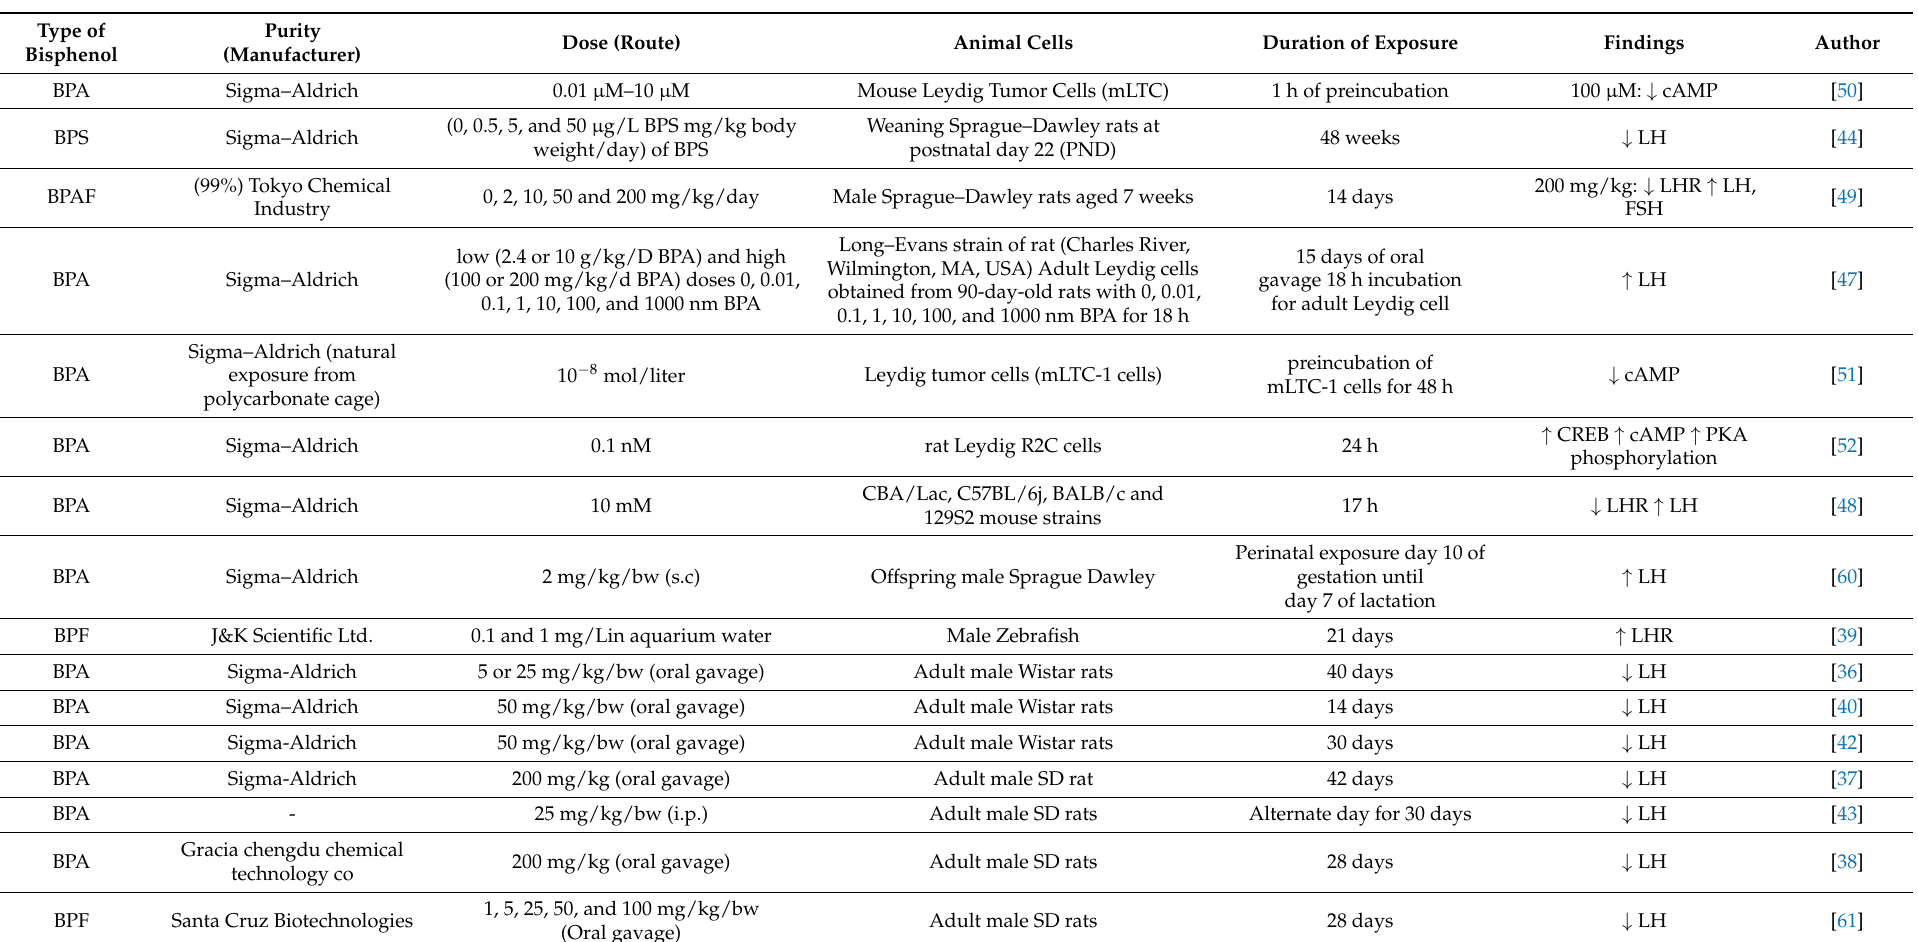
Table 2. The effects of BPA and its analogues on the LH, LHR and cAMP-PKA signaling pathways in the male reproductive system. Abbreviations: ↑ Increase; ↓